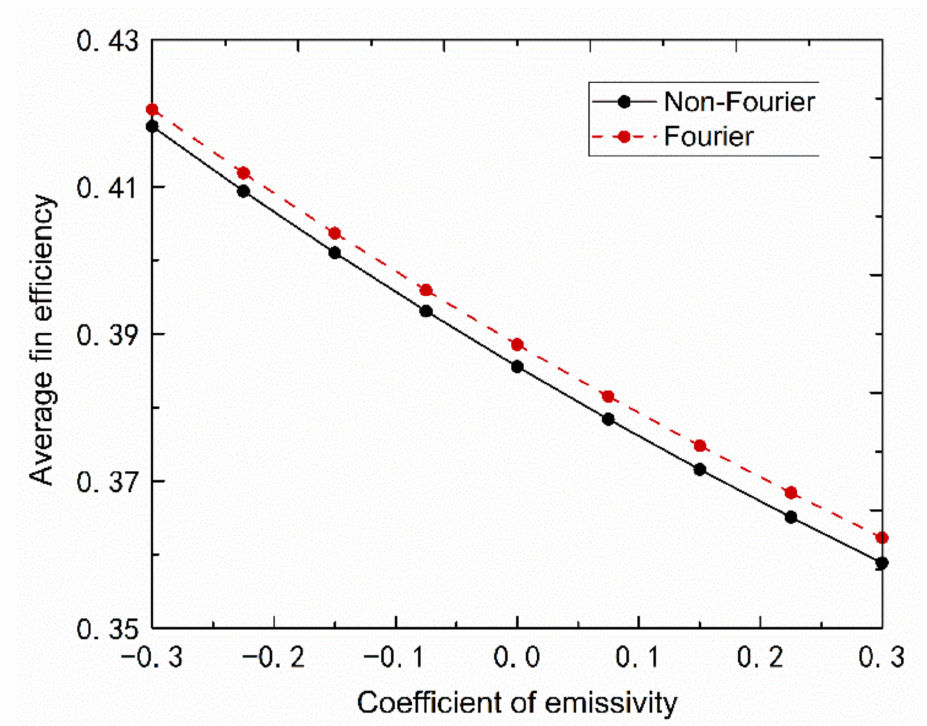
Figure 15. The variation of average fin efficiency with different values of ξ